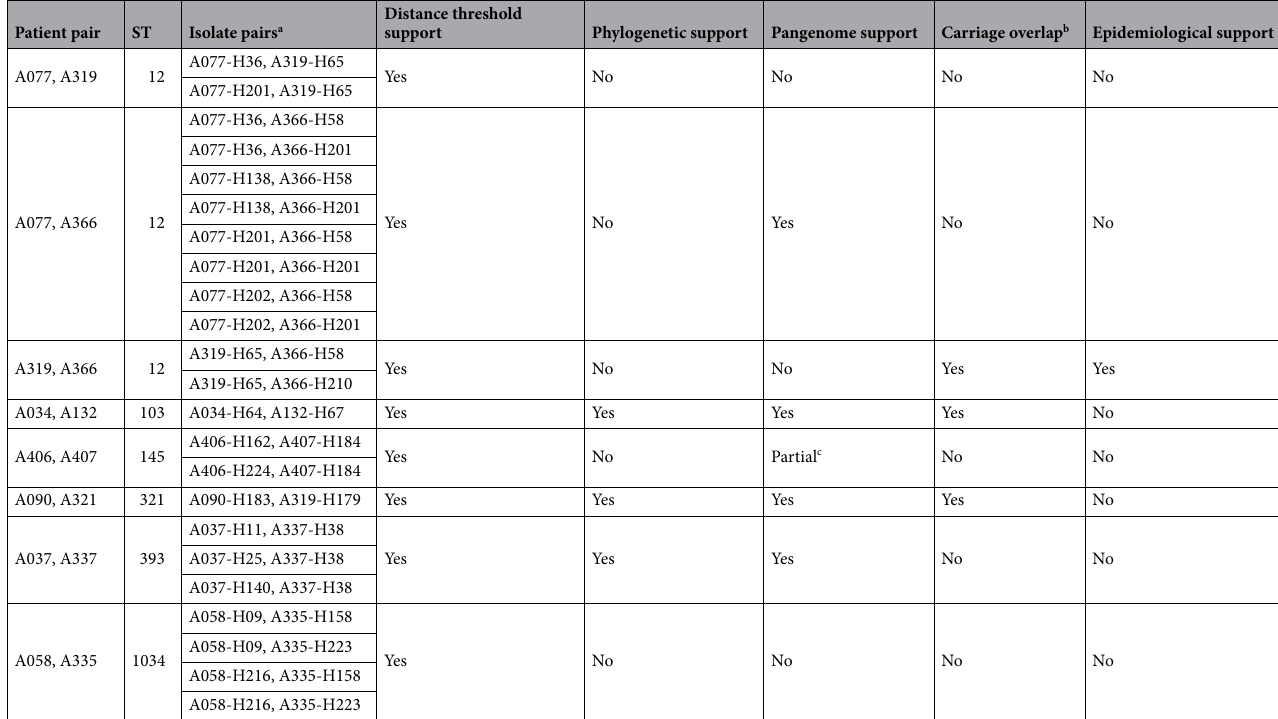
Table 2. Support for infection transmission between patient pairs with potentially transmitted isolates. All isolate pairs that had pairwise p-distances below a threshold of 1.68 × 10 −5 SNPs per site are included. a Isolate pairs are presented in the format “Patient Number-Isolate Number”. b Carriage overlap refers to detection of the associated H. influenzae isolates in both patients within 6 months of each other. It is a sub-category of Epidemiological Support. c Patient A407’s isolate clustered with one of patient A406’s isolates; the second isolate from patient A406 clustered separately from their